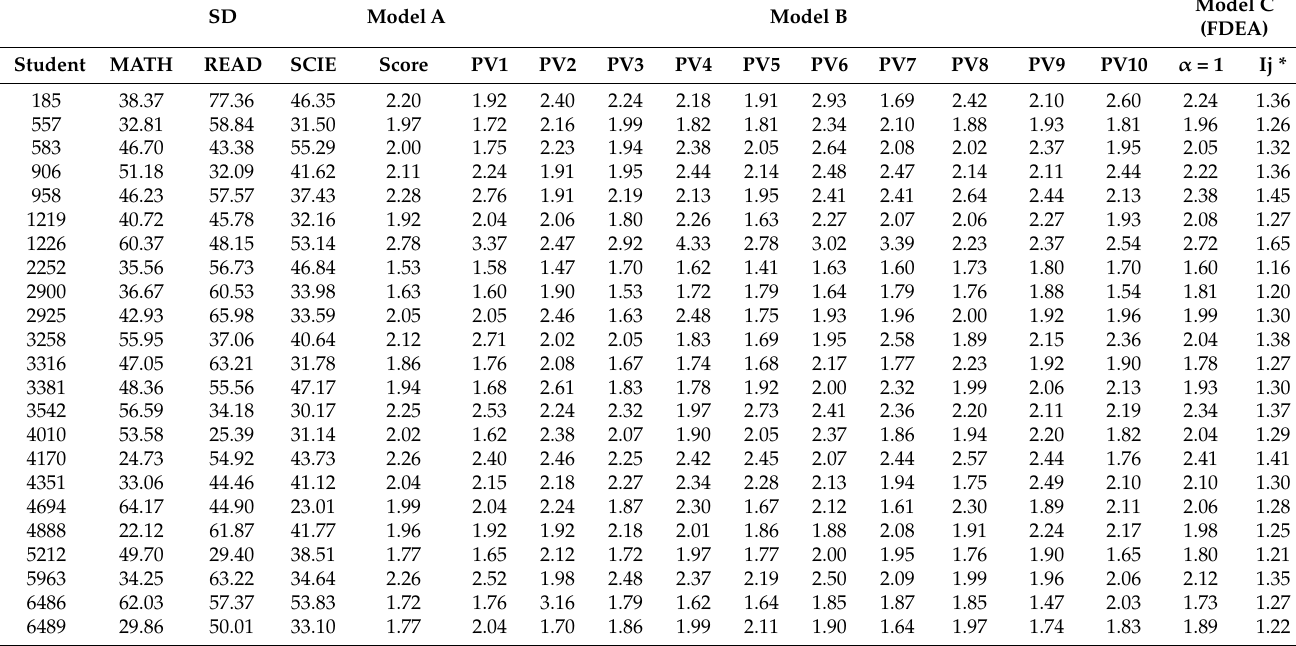
Table 6. Efficiency scores for students with the highest dispersion in their plausible values.